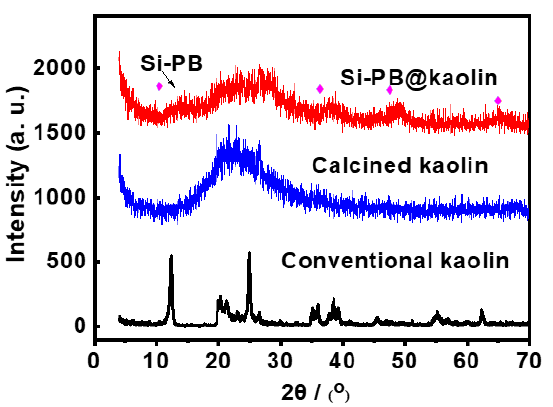
Figure 1. XRD patterns for kaolin, calcined kaolin and Si-PB@kaolin composite.